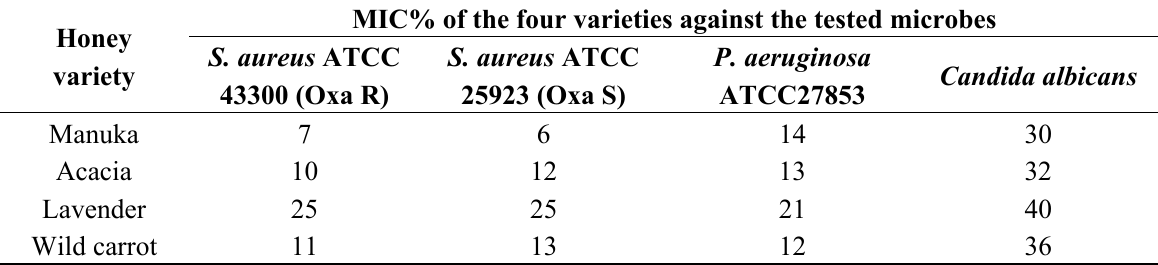
Table 3. The antibacterial potency of honeys against the tested